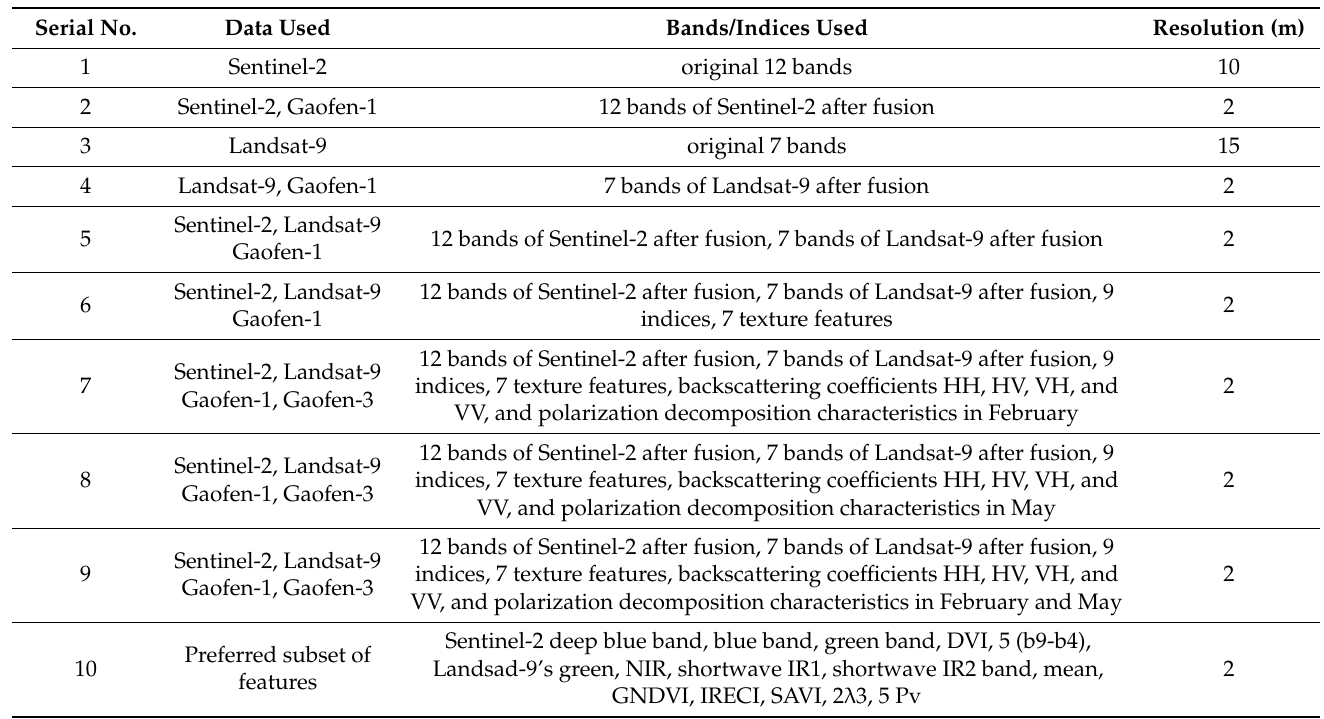
Table 4. Feature combination scheme, Sentinel-2, Landsat-9, and Gaofen-3 data and derived fea- ture parameters. The polarization decomposition parameters include λ 1, λ 2, λ 3 eigenvalues and the volume scattering, surface scattering and double-bounce scattering components of Freeman decomposition (2 λ 3 represents the λ 3 eigenvalue in February; 5 Pv represents the volume scattering component in